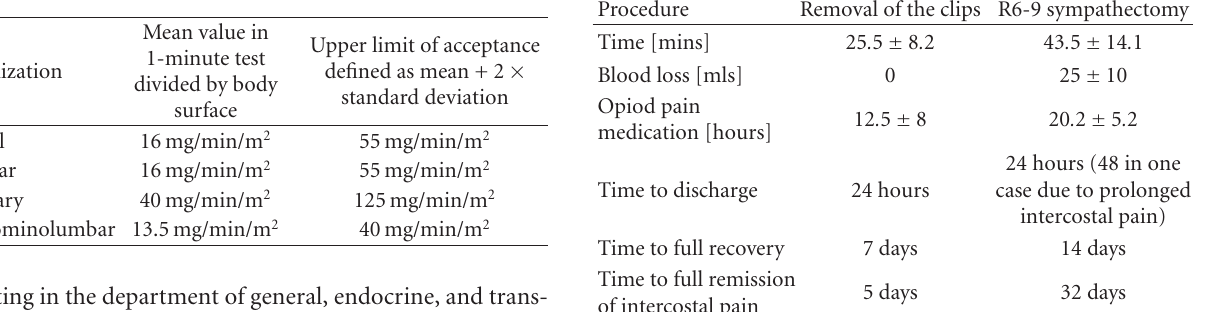
Table 1: Reference values of sweating in di ff erent localizations evaluated with gravimetry [11].